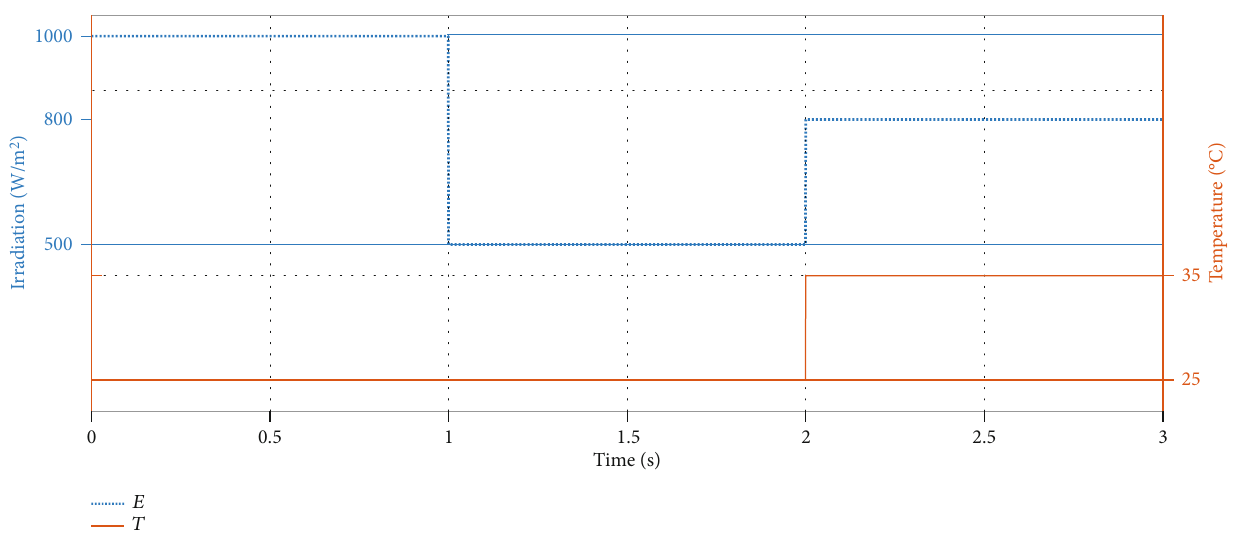
Figure 8: Pro fi les of irradiation and